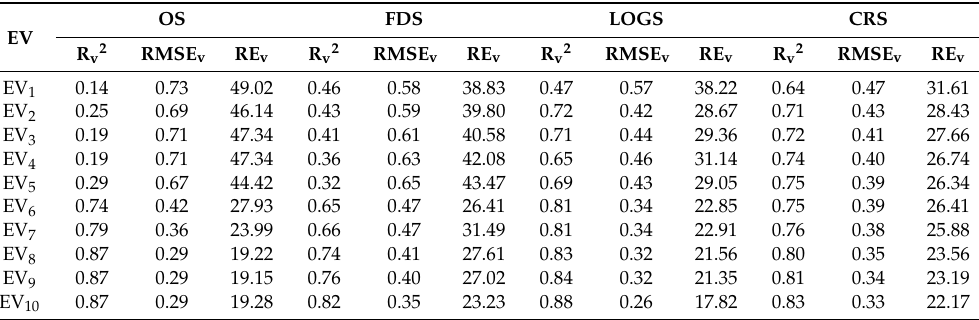
Table 7. The coe ffi cient of determination, root mean square error and relative error of the validation set based on a partial least squares regression with wavelet energy values. EV i denotes energy value (EV) at decomposition level i.